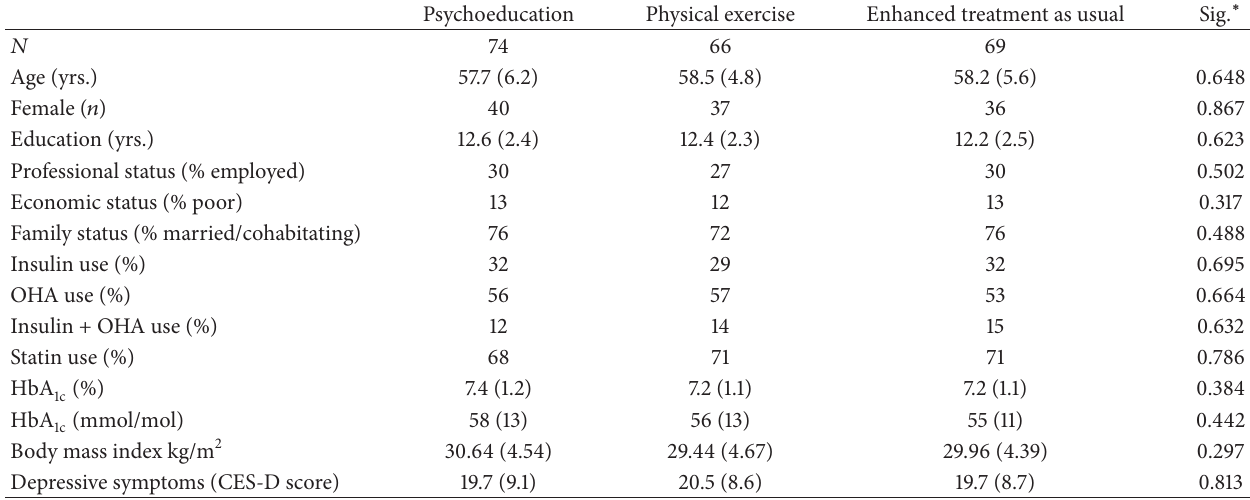
Table 2: Baseline characteristics of participants by the intervention groups ( 𝑛 = 209